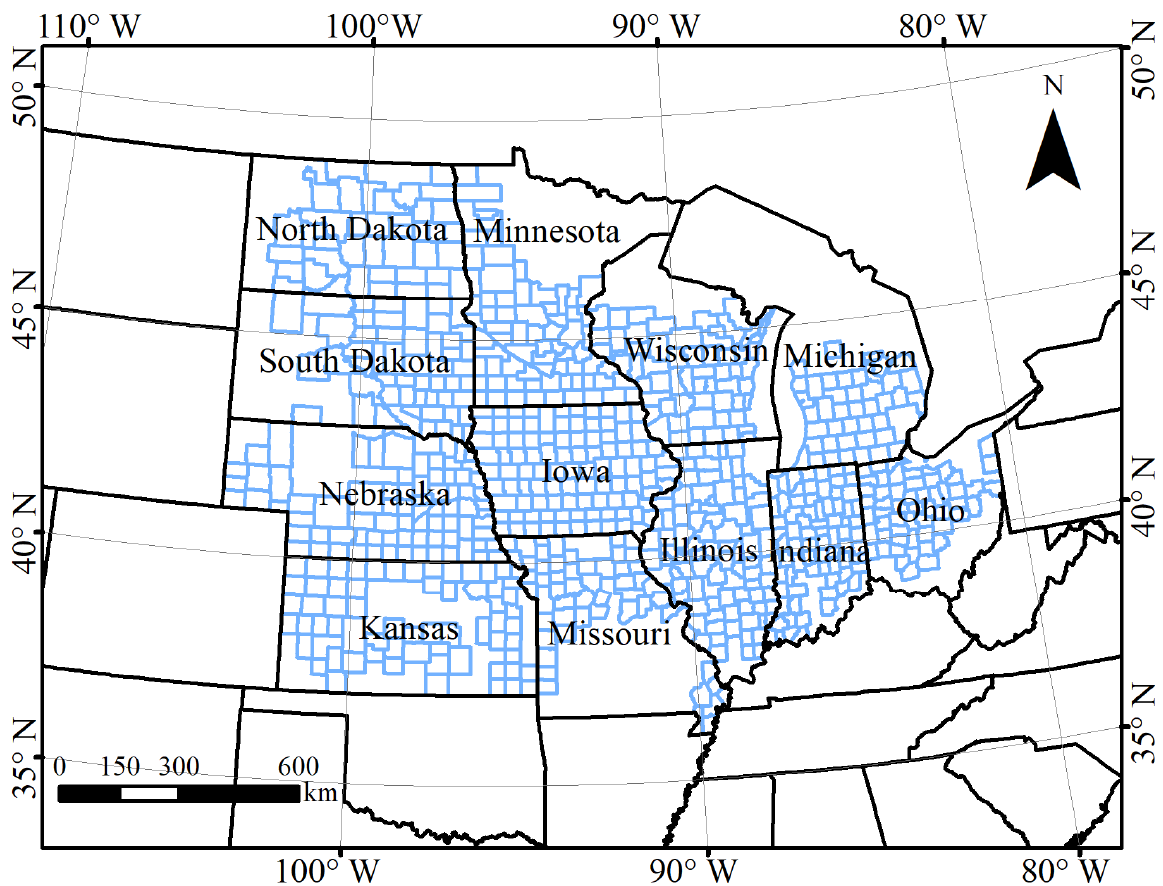
Figure 1. Spatial distribution of 766 counties selected for use in the study.